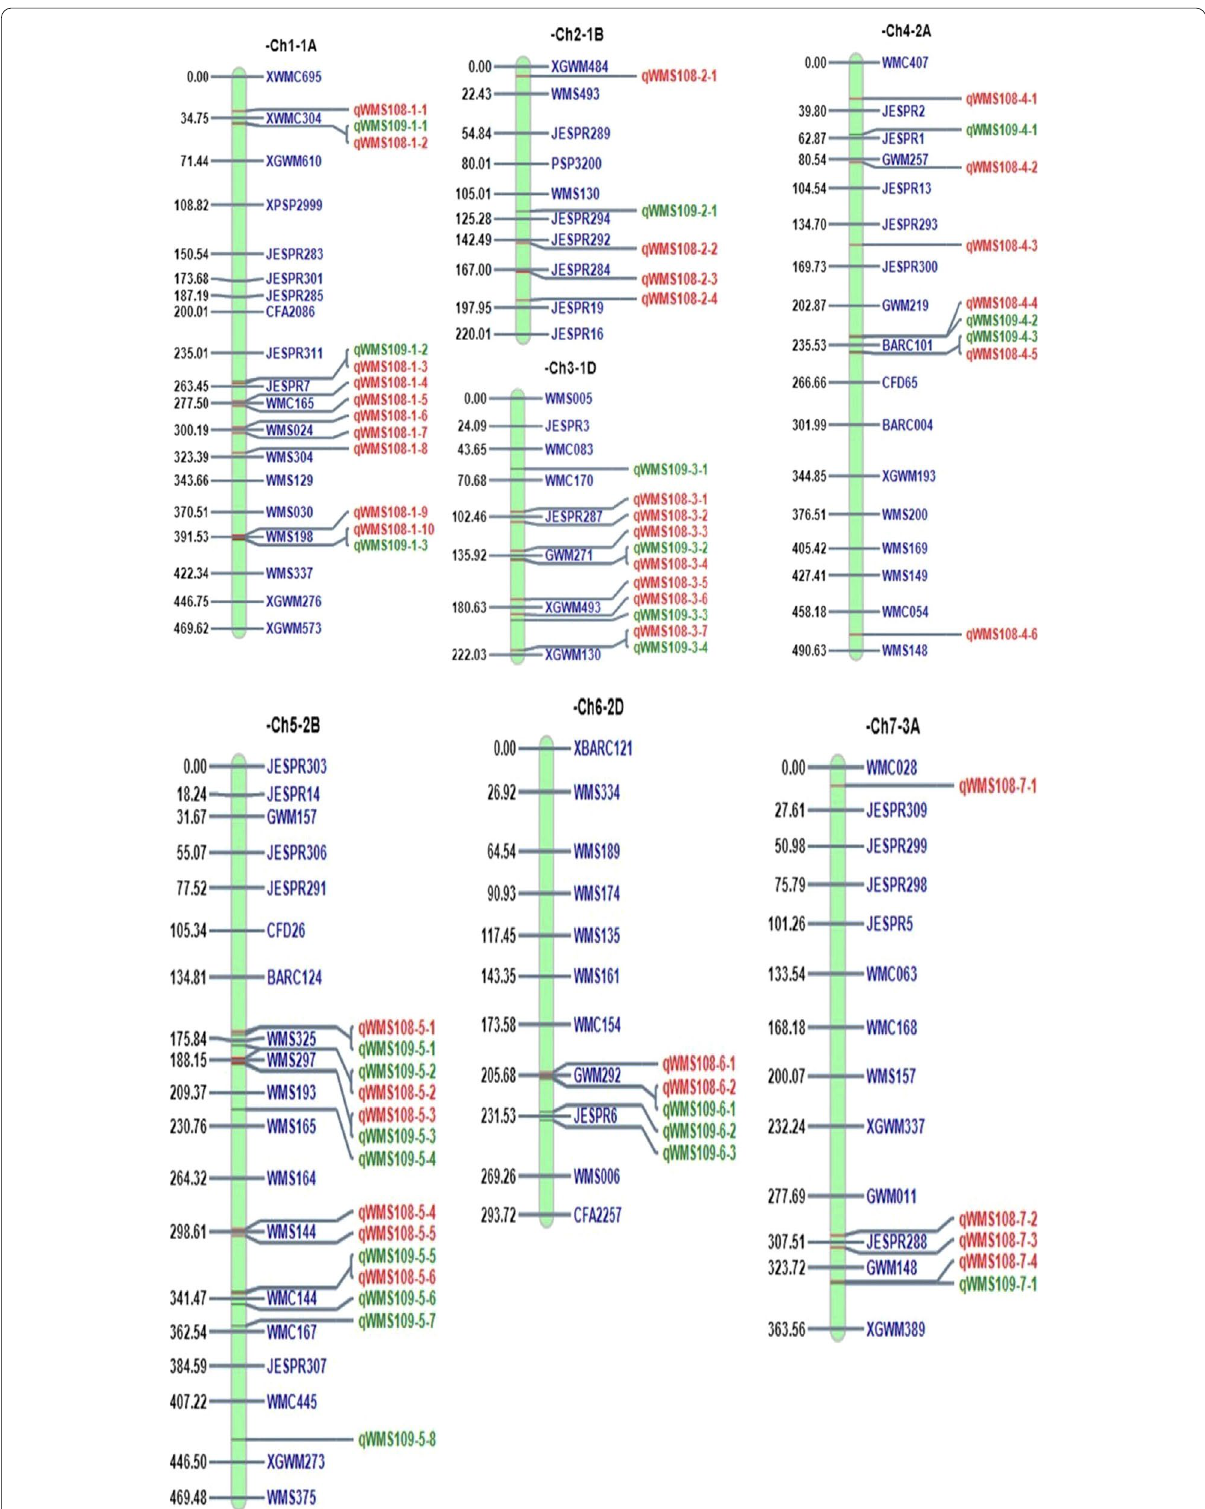
Fig. 2 Linkage maps revealed the position and distribution the QTLs related to plant height and leaf wilting among Wheat chromosomes. QTL name on the right side and centimorgan (cM) distance on the left. A colored bar represents the CI (confidence interval) of QTL identified through single‑locus